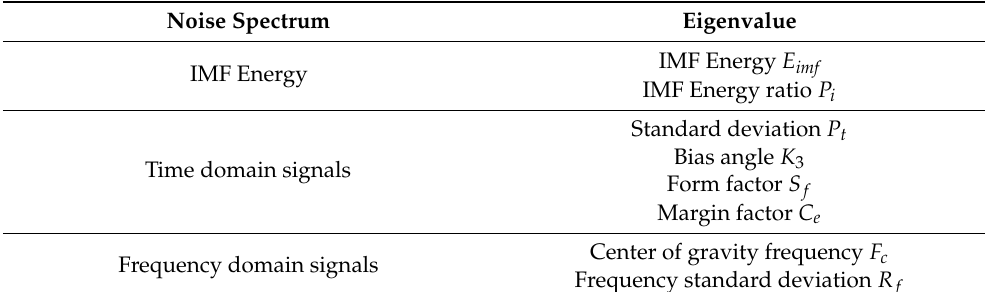
Table 1. Eigenvalues of the friction-induced vibrations in WLBs.